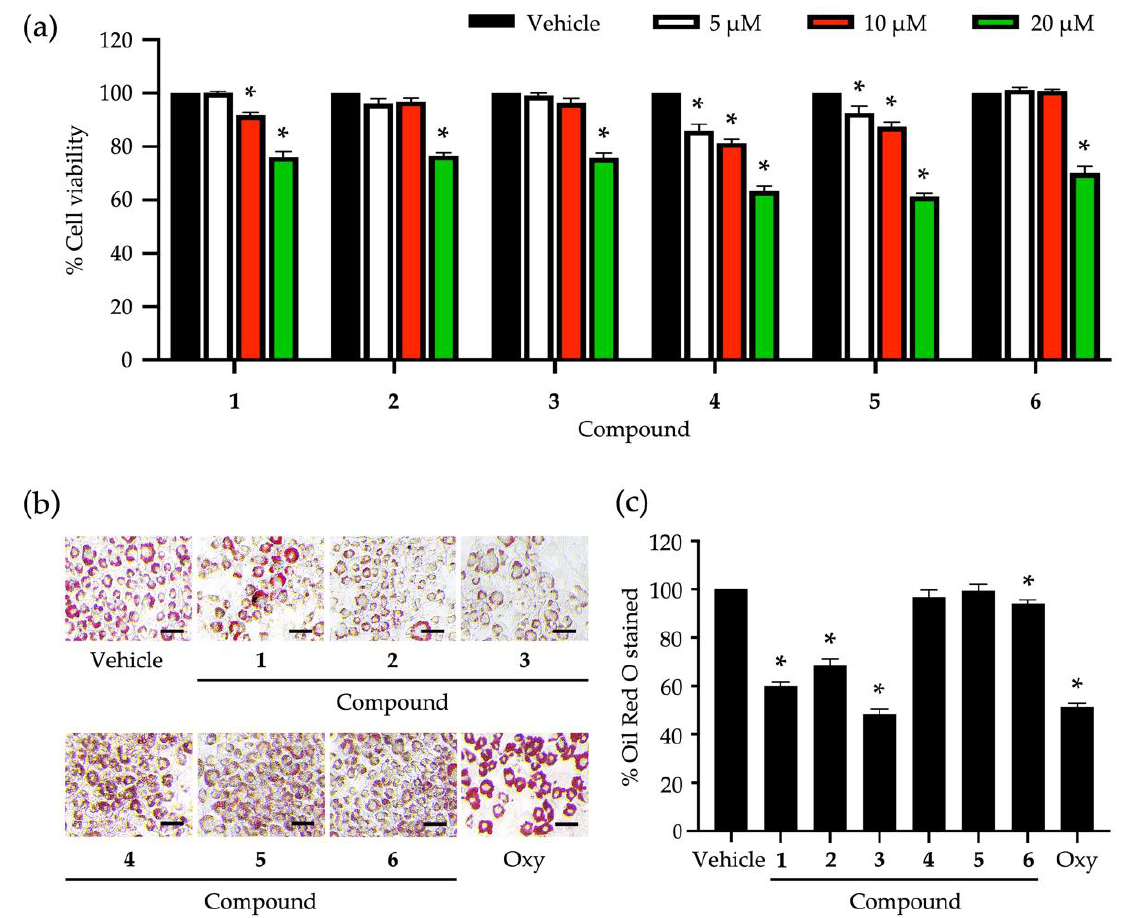
Figure 2. Roles of secondary metabolites eluted from Dendrobium heterocarpum in the viability and lipid storage of adipocytic cells. The percentage of cell viability was accounted for after treating 3T3-L1 cells with varying tested concentrations (5, 10, and 20 µ M) of compounds 1 – 6 for 48 h ( a ). The impact of compounds 1 – 6 at the concentration of 5 µ M on the lipid storage of 3T3-L1 cells was assessed using the Oil Red O staining method ( b ); scale bars = 20 µ m. The percentage of Oil Red O stained was computed after the normalization with the total cellular protein ( c ). The graphical results demonstrate means ± SDs derived from three independent experiments. The asterisk (*) represents a statistical difference at p < 0.05 between the treatment and untreated vehicle control made of 0.5% ( v / v ) dimethyl sulfoxide, assessed by one-way ANOVA with Tukey’s post hoc test. A positive control made of 20 µ M of oxyresveratrol (Oxy) might be included in some